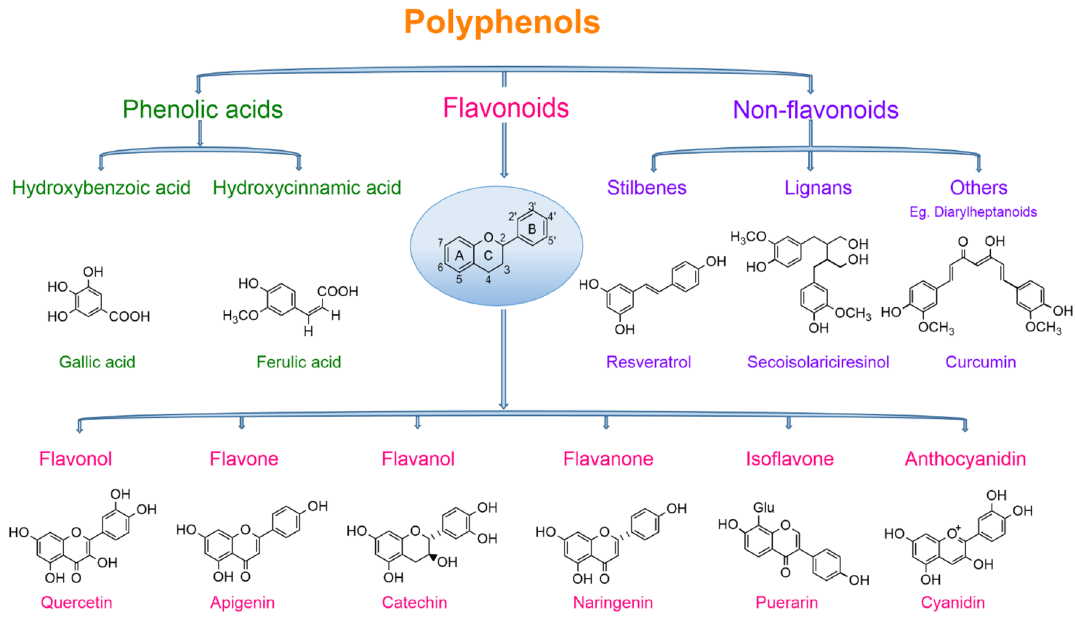
Fig. 2 Classification of